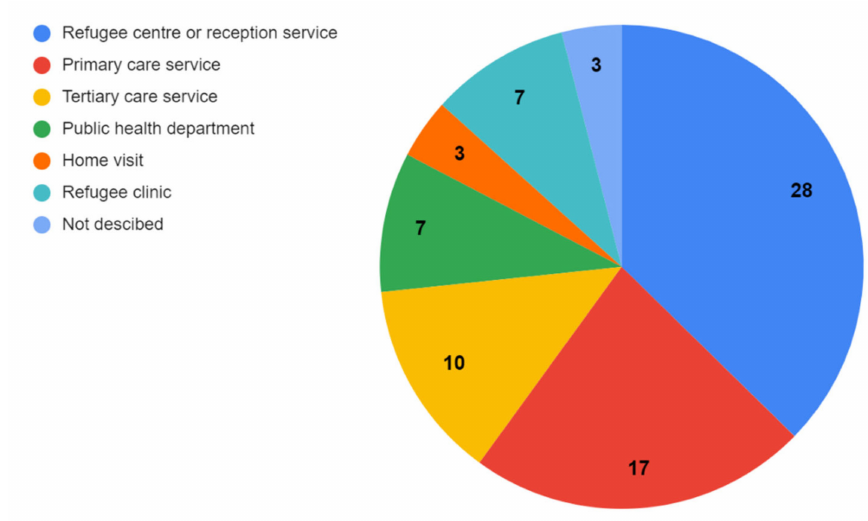
Figure 5. Setting of mental health assessments.